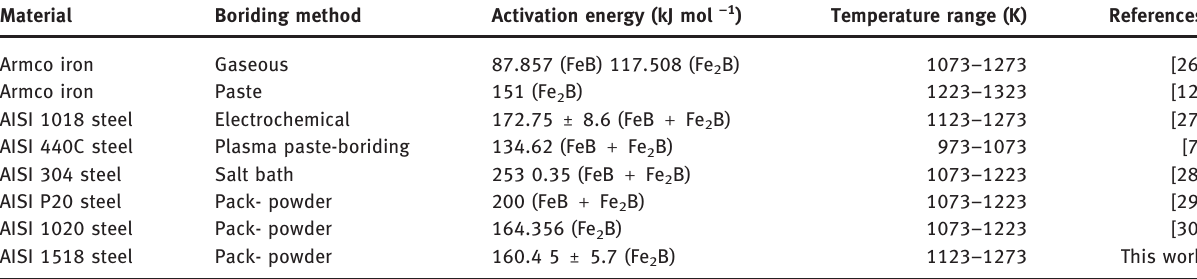
Table 3: Comparison of activation energy for boron diffusion in AISI 1518 steel with other borided materials (Armco iron and steels). Material